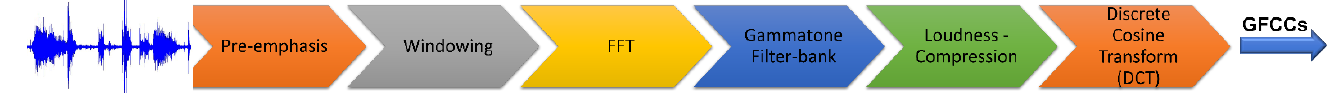
Figure 3. Block diagram of GFCCs feature extraction module.